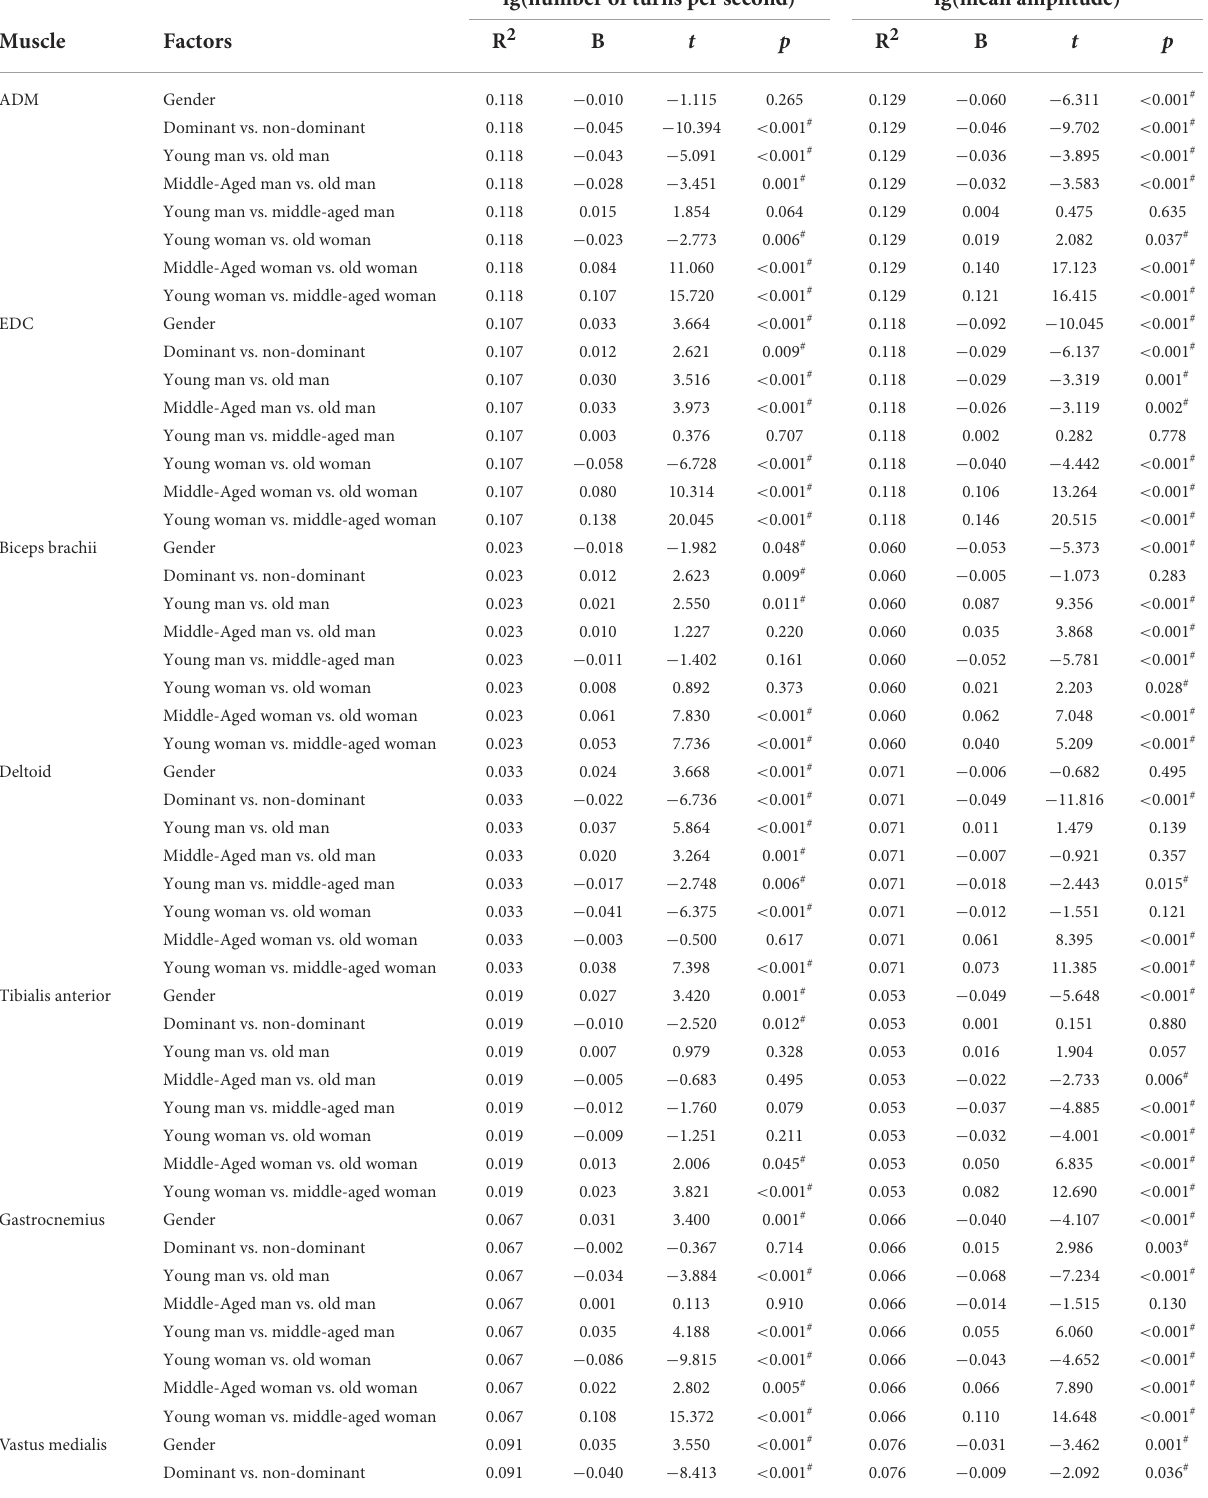
TABLE 6 The comparison of the results of lg (number of turns per second) and lg (mean amplitude) using multiple linear regression model. lg(number of turns per second) lg(mean amplitude) Muscle Factors ADM